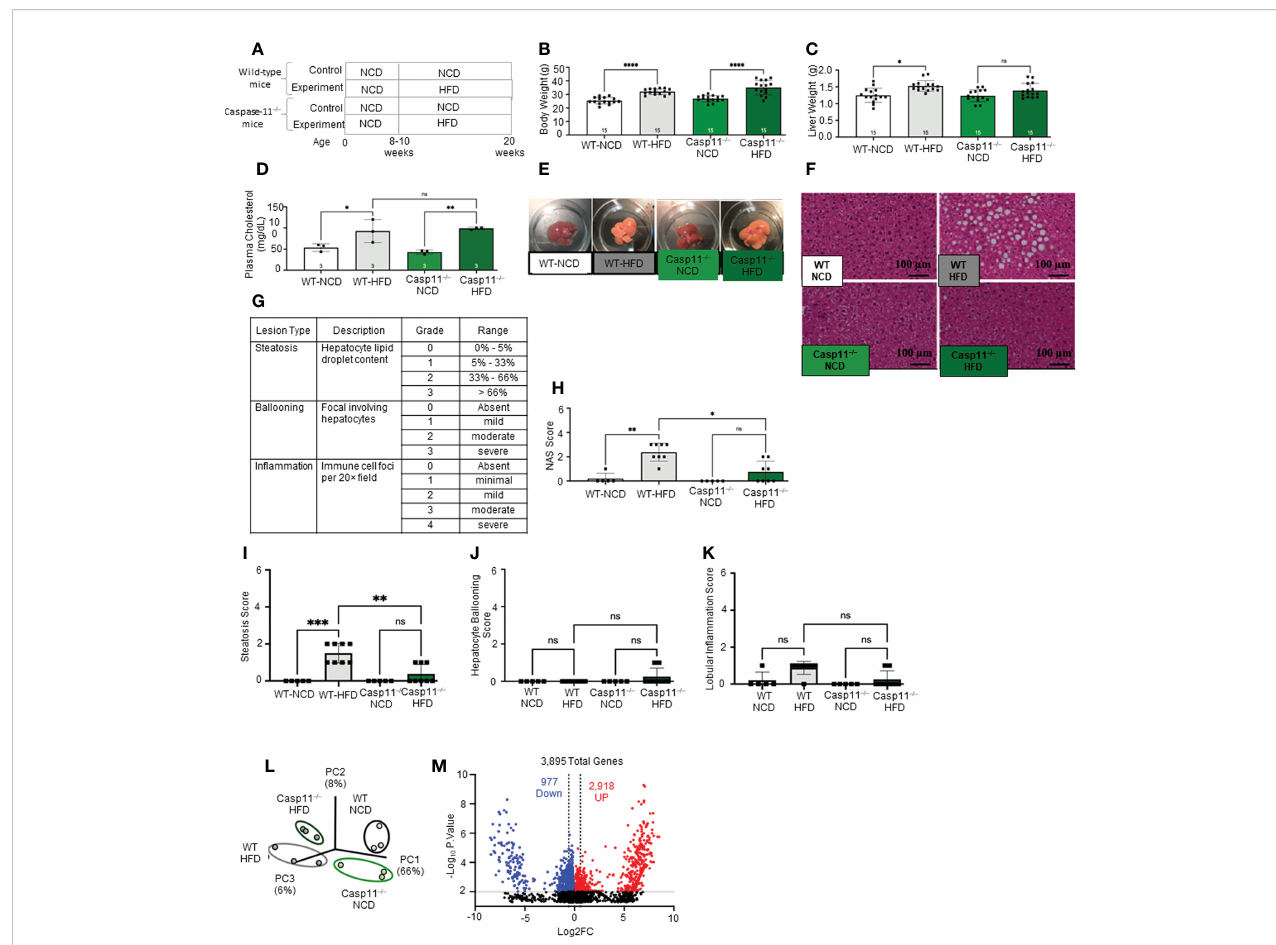
FIGURE 1 High-fat diet (HFD) promotes non-alcoholic fatty liver disease (NAFLD) and Caspase-11 de fi ciency decreases lipid droplet, steatosis score, and NAS score in HFD-induced NAFLD but does not change liver weight or gross anatomic fatty liver pathology. (A) Experimental diet timeline. 8-10 weeks old Wild-type (WT) male mice and Caspase-11 de fi cient (Casp11 – / – ) mice were fed HFD or normal chow diet (NCD) for 12 weeks. (B) Body weight (n = 15). (C) Liver weight (n = 15). (D) Plasma cholesterol levels (n = 3). (E) Representative images showed that HFD feeding changed liver color to light yellow color. (F) Representative 20X images of hematoxylin and eosin (H&E) staining showing hepatic steatosis in 12-week HFD-fed WT and Casp11 – / – male mice compared to 12-week NCD. Scale bar 100 µm. (G) . Description and grades of NAS scare. NAFLD activity score analysis indicated that lipids accumulation as judged by liver steatosis and ballooning is precedent to liver in fl ammation. In grade 1, when steatosis reaches 5-33%, and ballooning reaches mild, in fl ammation is minimal. Steatosis was in the graded section as: are 0, steatotic; 0% to 1, 5% greater than 5% to 33% of hepatocytes are steatotic; 2, greater than 33% to as: 66%; 0, absent; and 3, 1, greater mild (focal; than 66%. involving Ballooning fewer than 3 hepatocytes); 2, moderate (focal and involving 3 or more hepatocytes or multifocal); and 3, severe (multifocal, with more than 2 foci of 3 or more hepatocytes). (0 or 1 In fl ammation focus per 20× was fi eld); graded 2, as: mild 0, (2 absent; foci);